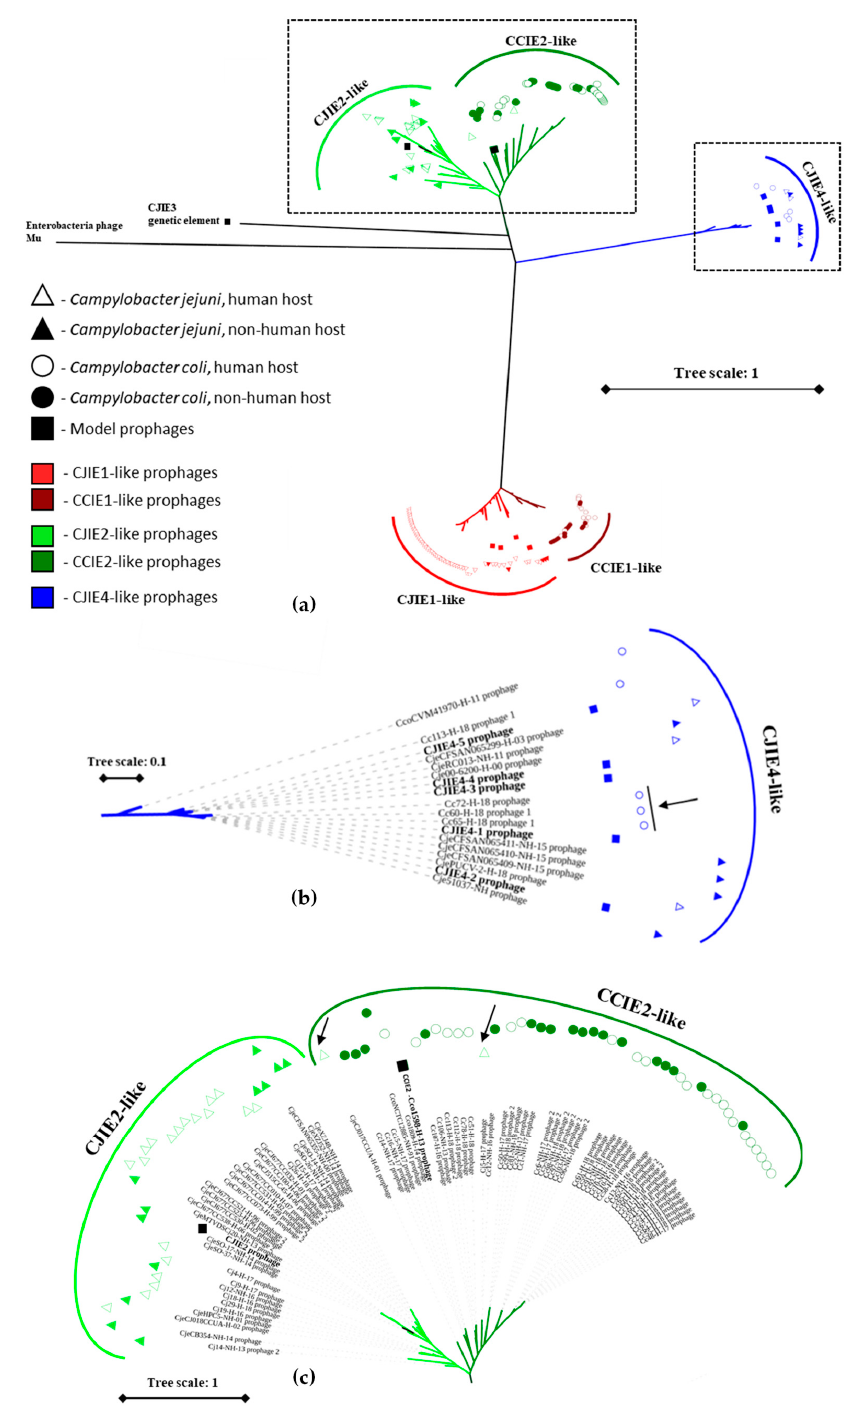
Figure 3. Phylogenetic tree of the identified CJIE1-like, CCIE2-like, and CJIE4-like prophages ( a ) and potential prophages host-jumps ( b , c ). CCIE2-like prophages are represented in green, CJIE1- like prophages are represented in red, and CJIE4-like prophages are represented in blue. The model prophages CJIE1-1 to 1-4, CJIE4-1 to 4-5, and CCIE2 prophage are represented as squares. CJIE2 and CJIE3 regions were extracted from C. jejuni RM1221 genome, included and represented as squares. Enterobacteria phage Mu is included as an outgroup and used to root the final tree. Prophages harbored by C. coli are represented as circles while prophages harbored by C. jejuni